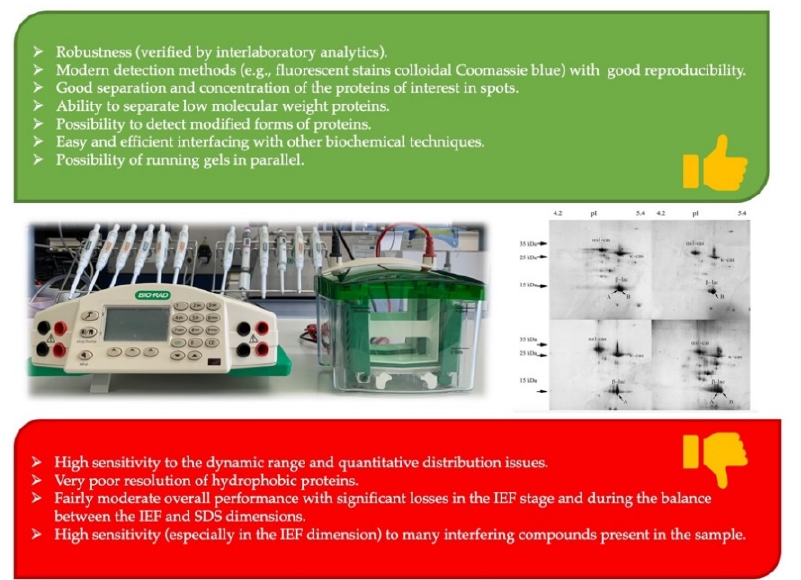
Figure 1. Advantages and disadvantages of two-dimensional gel electrophoresis (2DE) technology. Data from Rabilloud et al. [38]. Gel image from Zagorchev et al. [39]